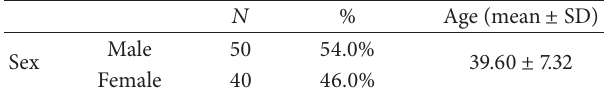
Table 1: Demographic data.